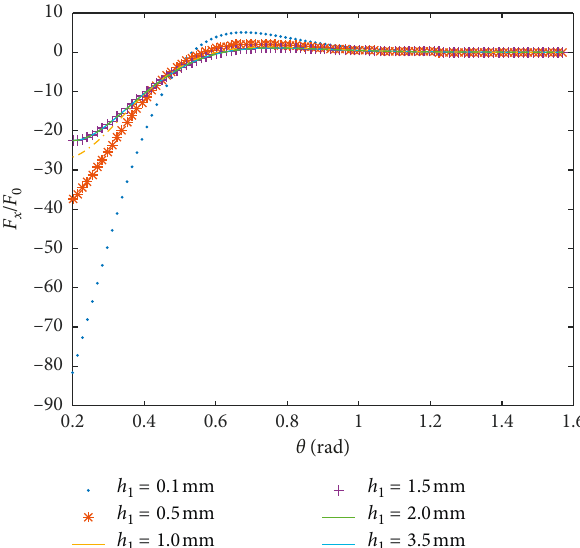
Figure 15: Relationship between image force F different values of parameter h